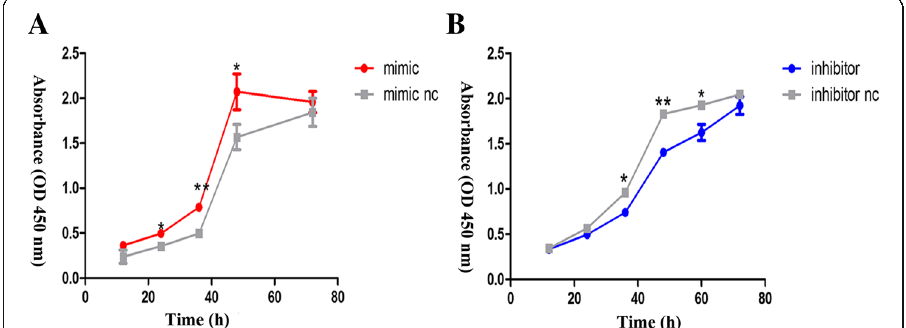
Fig. 2 miR-431-5p promoted A549 proliferation in vitro. a and b – CCK8 assay of cells transfected with miR- 431-5p mimic, inhibitor, mimic nc or inhibitor nc. * p < 0.05; ** p < 0.01 vs. miR-431-5p negative